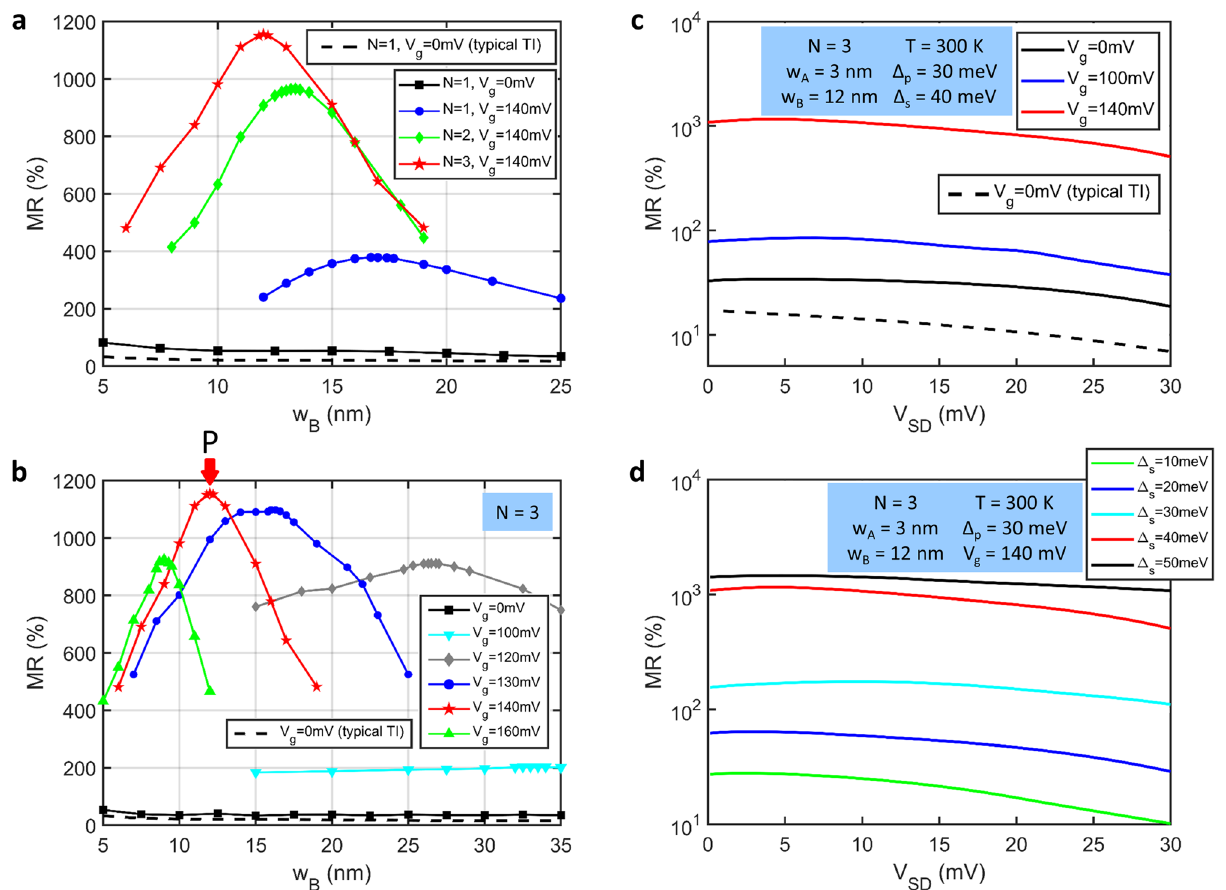
Figure 3. ( a ) Room-temperature MR ratio versus gate length in TITF spin valves with different period number N. The black and black-dashed curves represent the MR ratio of the standard TITF and typical TI spin valves without the gate potential, respectively, where the value of w B is taken as the period length Λ p (Λ p = w A + w B ). ( b ) Room-temperature MR ratio versus gate length with different potential heights for N = 3. Here, w B indicates the period length Λ p when V g = 0 mV. The corresponding value of the length w A is given in Supplementary Information for details. The other parameters are the same as those shown in Fig. 2a. ( c ) Bias-dependent MR value for the 3-cell potential spin valve at room temperature with different V g . ( d ) Bias-dependent MR value with different Dirac gap Δ s